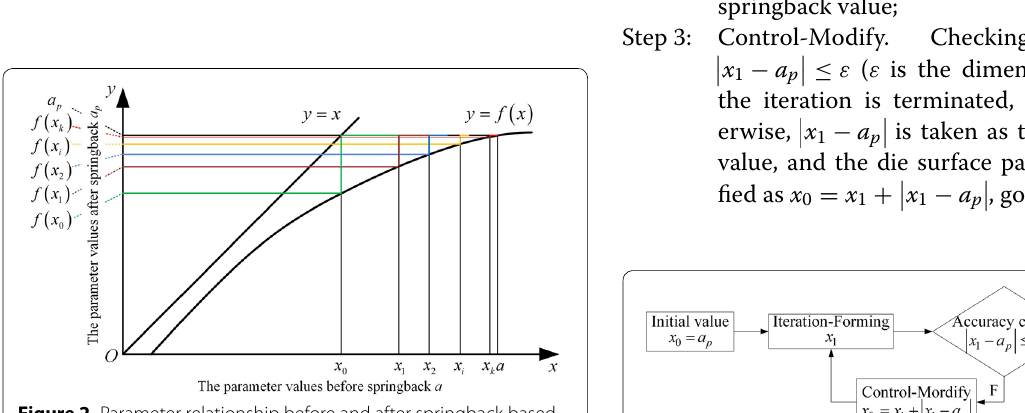
Figure 2 Parameter relationship before and after springback based on simple iteration method Figure 3 Iterative compensation process for springback